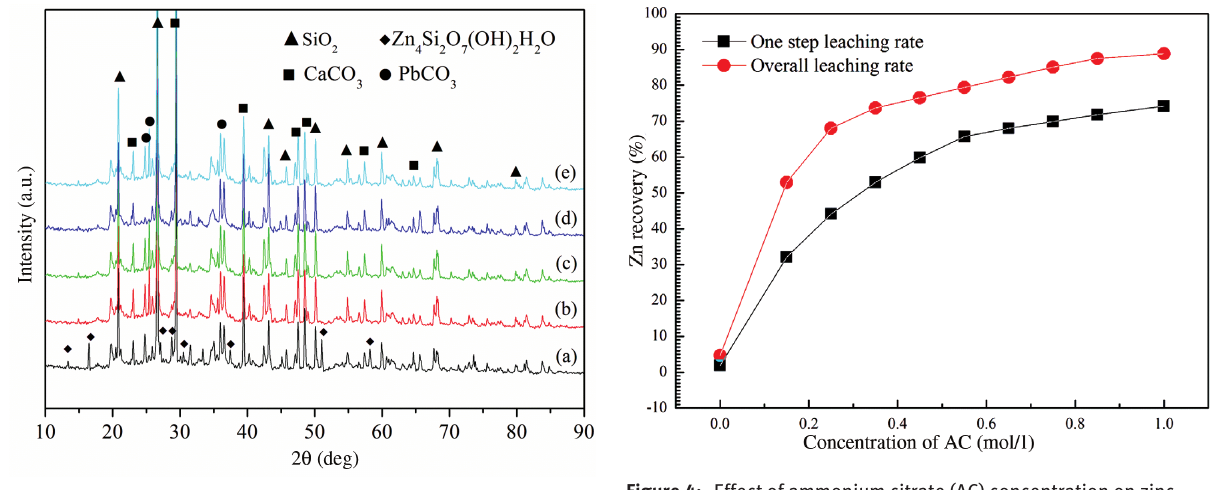
Figure 3: X-ray diffraction (XRD) patterns of two steps leaching slags formed in different solutions: (A) No. 2 solution; (B) No. 4 solution; (C) No. 6 solution; (D) No. 8 solution; (E) No. 10 solution.